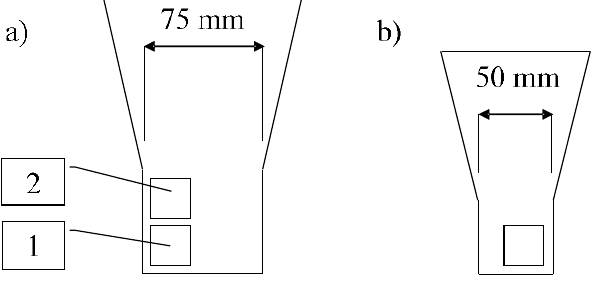
Figure 1. Position of specimens for tensile tests (according to UNI EN 1563:2012) taken from the Y-shaped type IV ( a ) and type III ( b ).